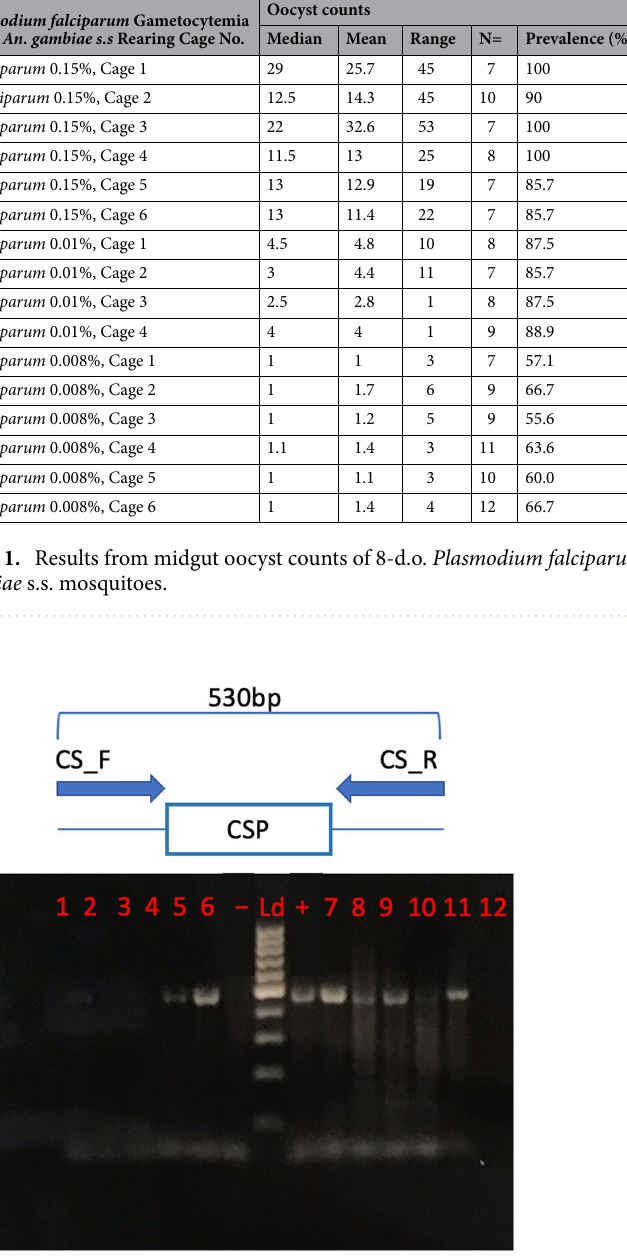
Figure 2. ( A ) Plasmodium falciparum circumsporozoite (CS) primer set schematics indicating expected PCR amplification products. ( B ) Agarose gel (1.5%) electrophoresis of amplified products using CS primer set. Lanes 1–6 and 10–16 are a representative subset of the 176 examined P. falciparum sporozoite infected treatment Anopheles gambiae s.s. mosquitoes with a P. falciparum (+) positive and (−) negative control (blank). Lane Ld, 100 bp DNA size marker